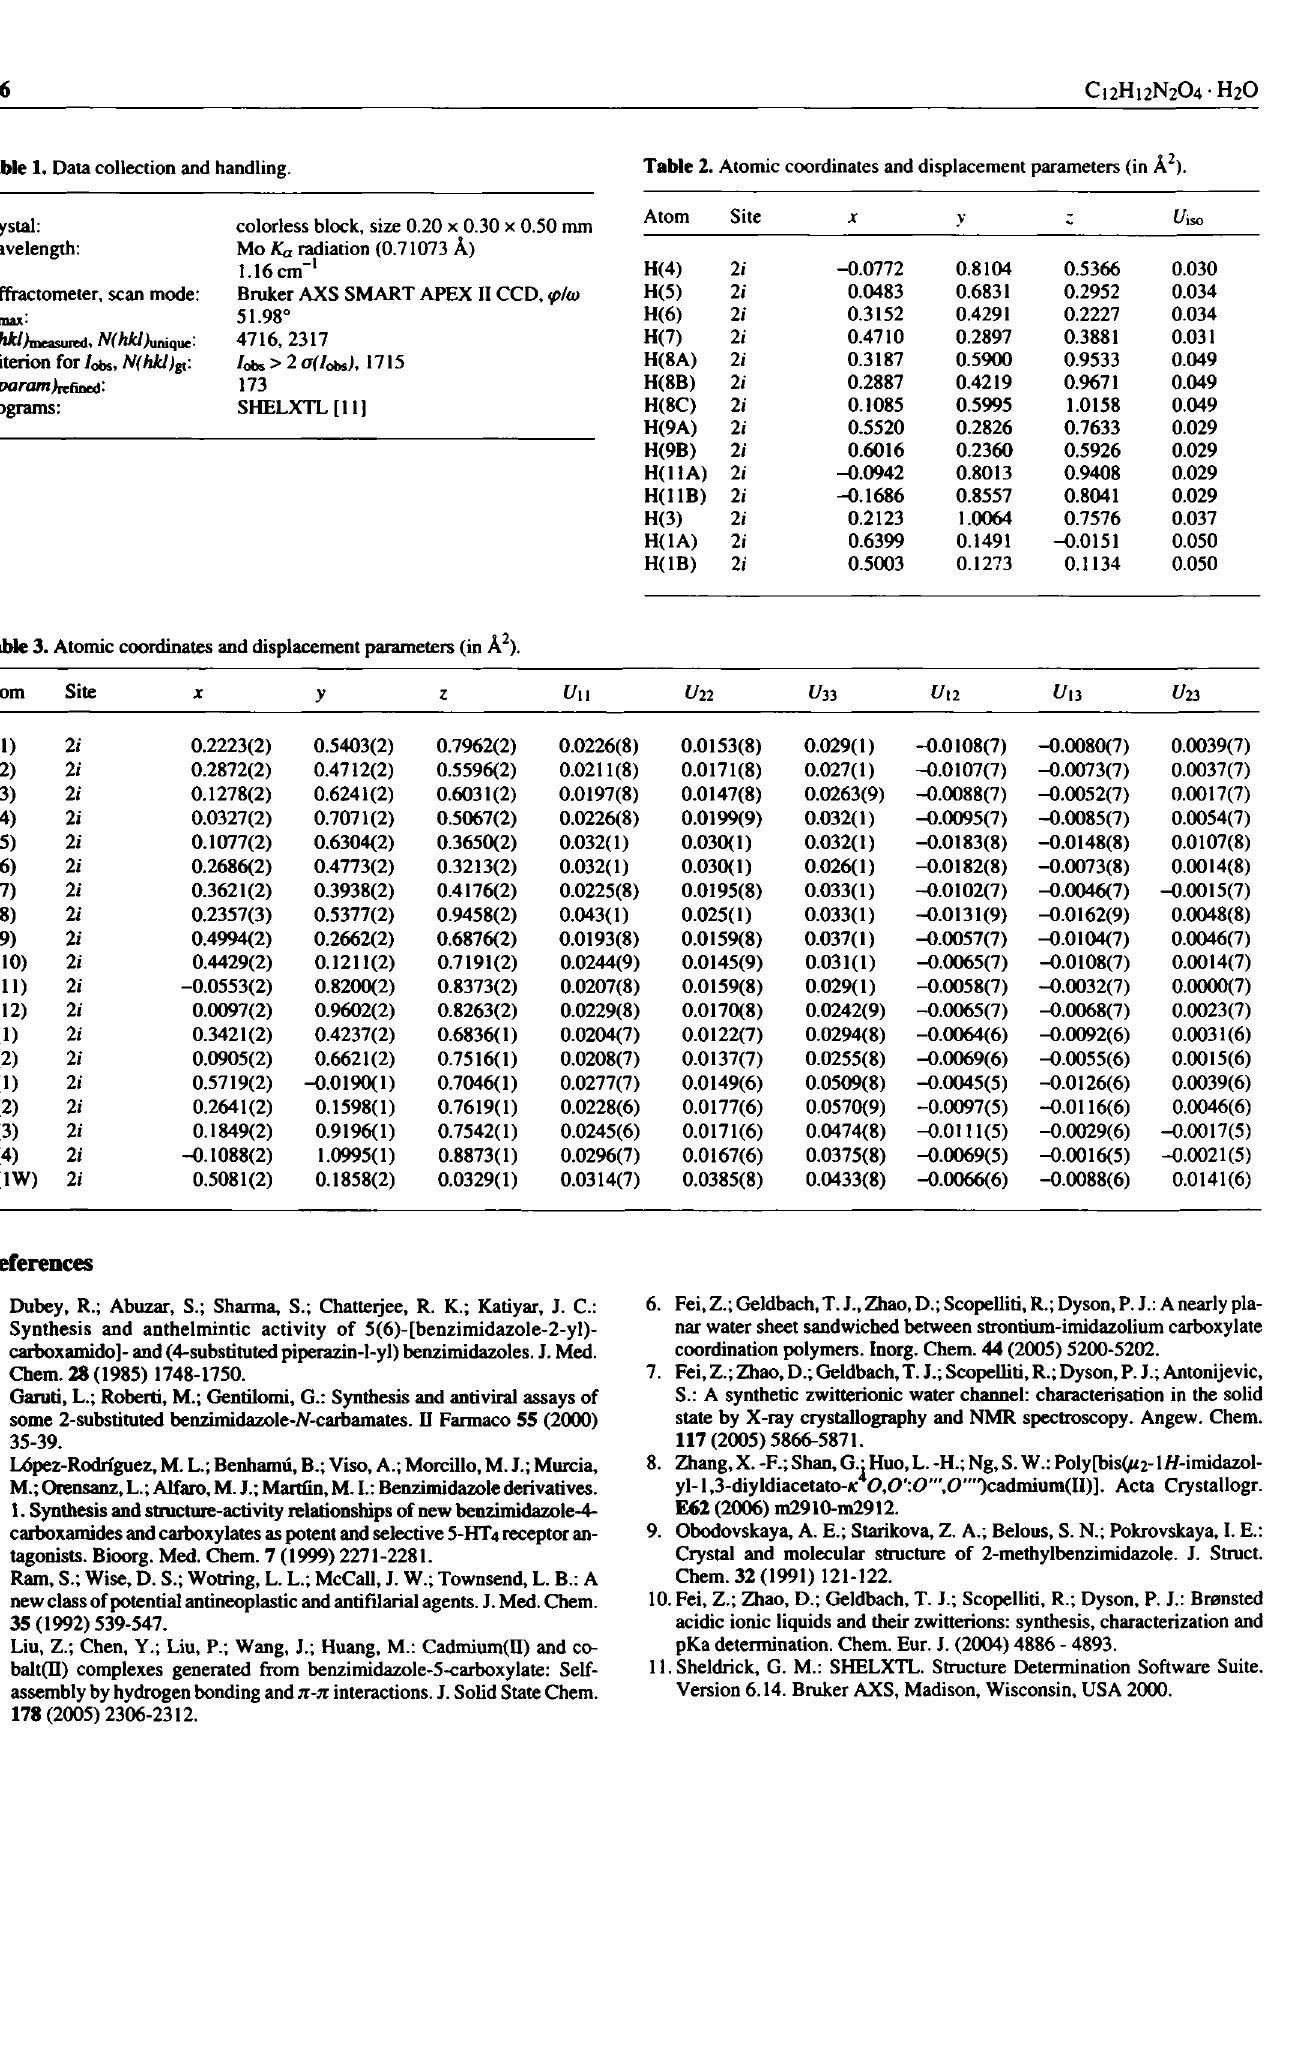
Table 1. Data collection and handling. Table 2. Atomic coordinates and displacement parameters (in Â 2 ).